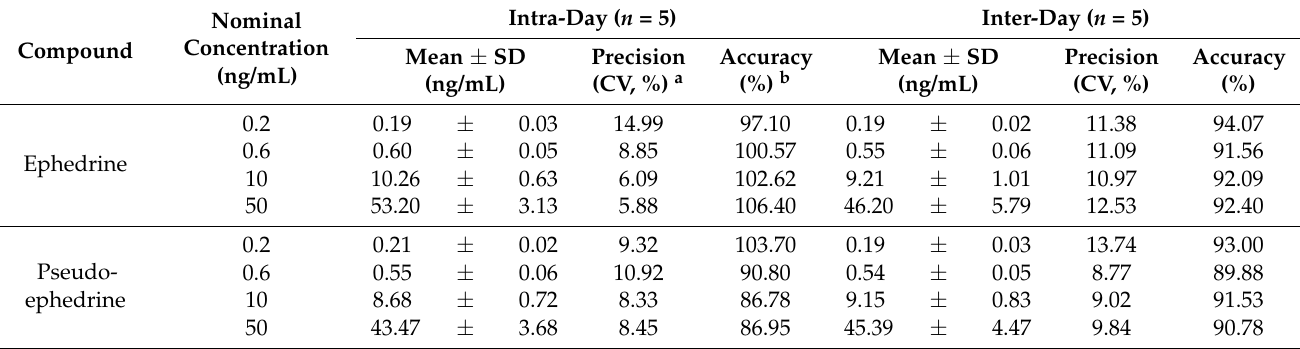
Table 1. Intra- and inter-day precision and accuracy of ephedrine and pseudoephedrine ( n = 5).